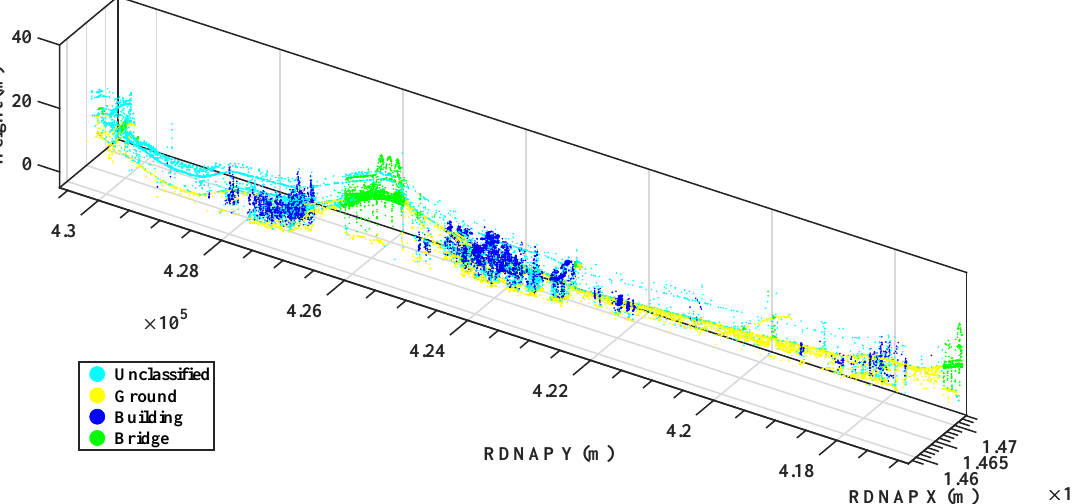
Figure 7. Classification of the radar scatterers with corrected coordinates based on their attribute to the LiDAR points, which are already